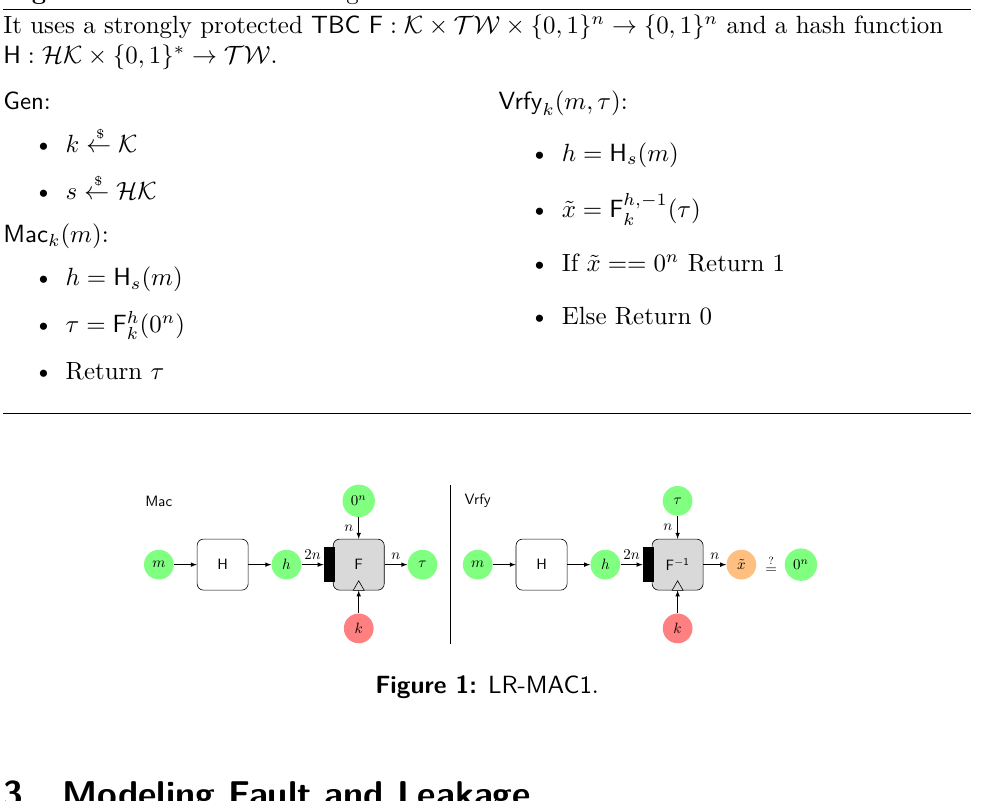
Algorithm 1 The LR-MAC1 algorithm.